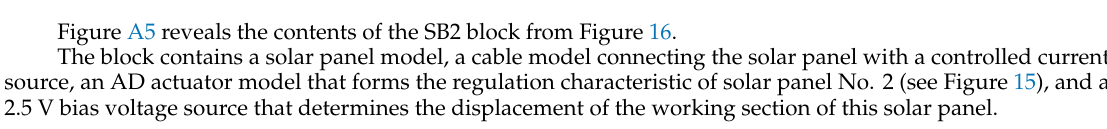
Figure A5. Model of solar panel No. 2 with analog equivalents of a pulse-width modulator and a shunt switch. References 1.